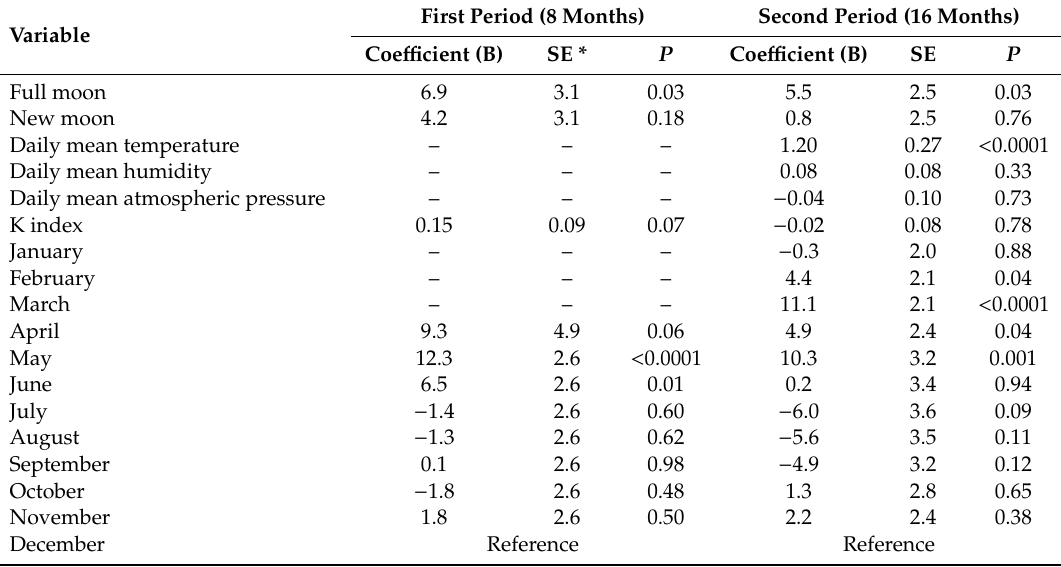
Reference Reference * SE: standard error.